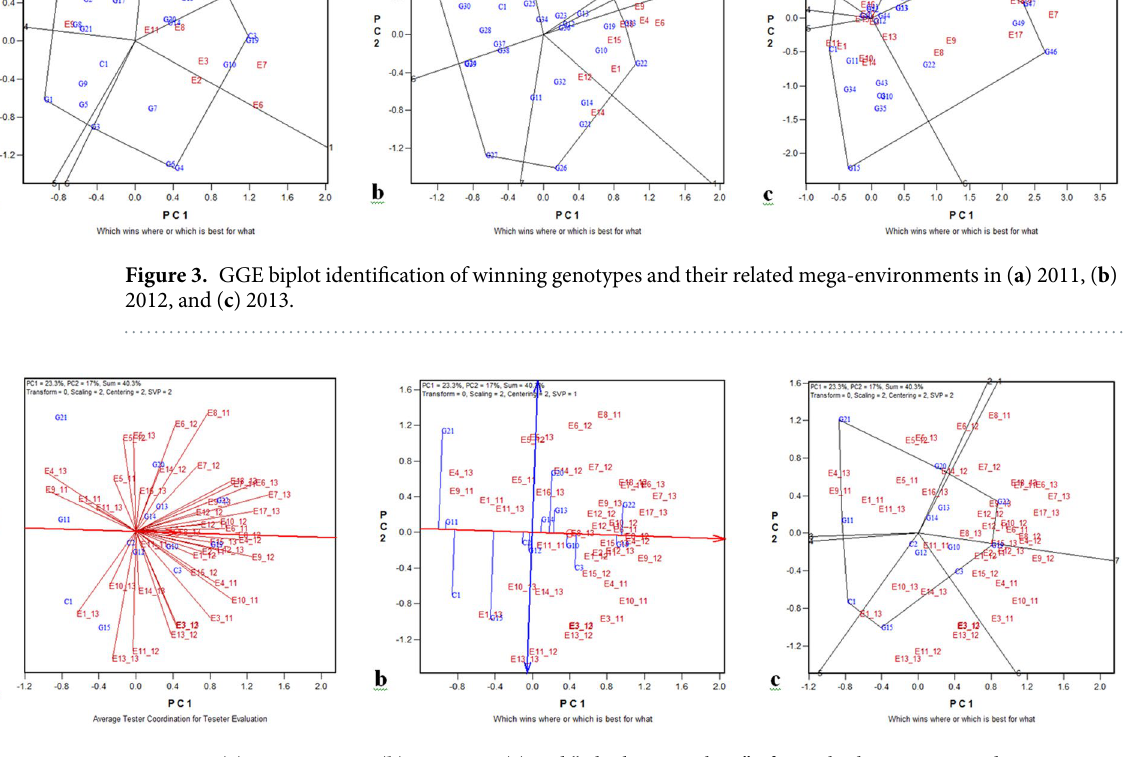
Figure 4. ( a ) Environment, ( b ) genotype, ( c ) and “which-won-where” of GGE biplots constructed using common genotypes tested across three years